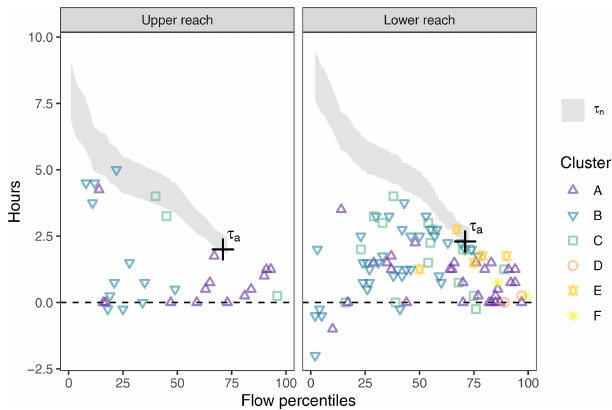
Figure 4. Time lag between diel NO − signals at adjacent moni- 3 toring points (colored symbols) compared to the tracer travel time ( τ a , black cross) and the range of nominal travel time estimates ( τ n , shaded area). No travel times were estimated when discharge ex- ceeded the validity range of the rating curve. The figure only shows lags determined from signals with a corresponding cross-correlation coefficient above 0.75 (84.0% of the days). Points falling below the shaded areas indicate in-stream control on diel NO − patterns, 3 whereas points within the range of travel time estimates suggest transport control.